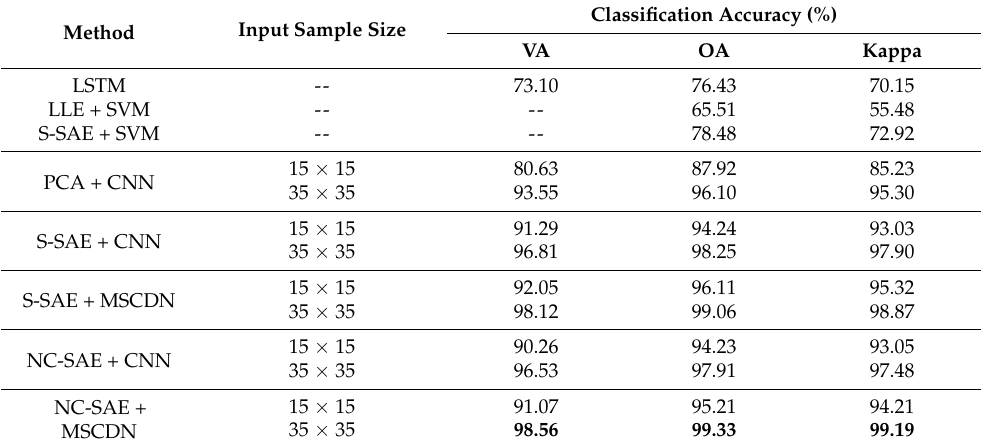
Table 9. Classification accuracy with different